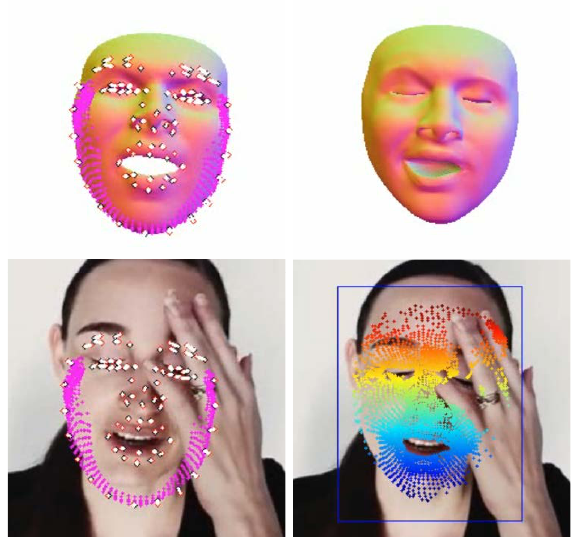
Fig. 5 Example of reconstruction with